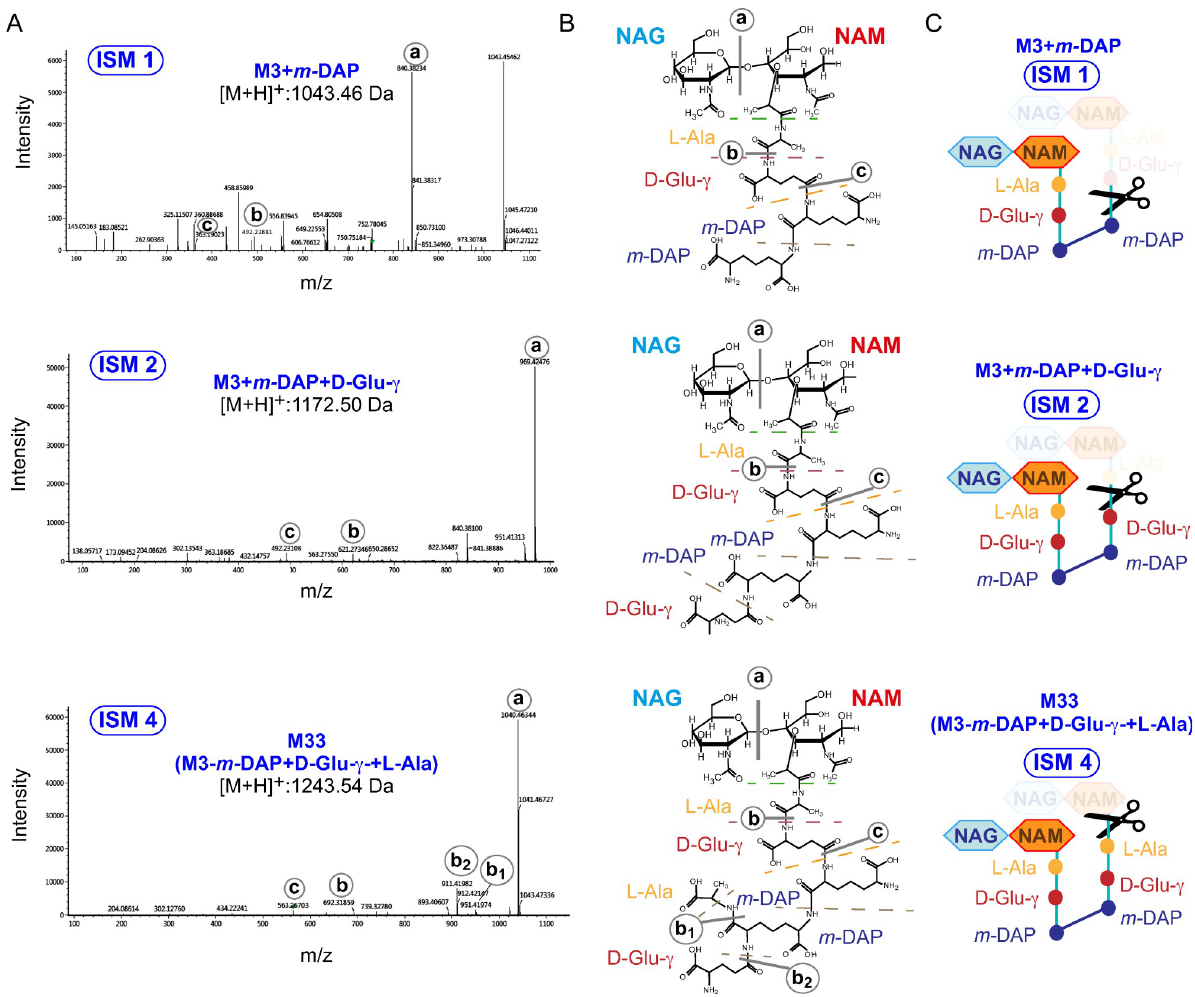
Fig 2. Identification in the PG of intracellular S . Typhimurium of muropeptides derived from the action of PG-cleaving enzymes on L,D- crosslinked muropeptides. (A) Fragmentation patterns were obtained by targeted MS of the indicated ions. Theoretical values calculated for the parental ions are shown. (B) Chemical structure determined for each muropeptide and (C) schematic representation of the cleaving activity on a D33 dimer resulting in each of the ISM muropeptides, are